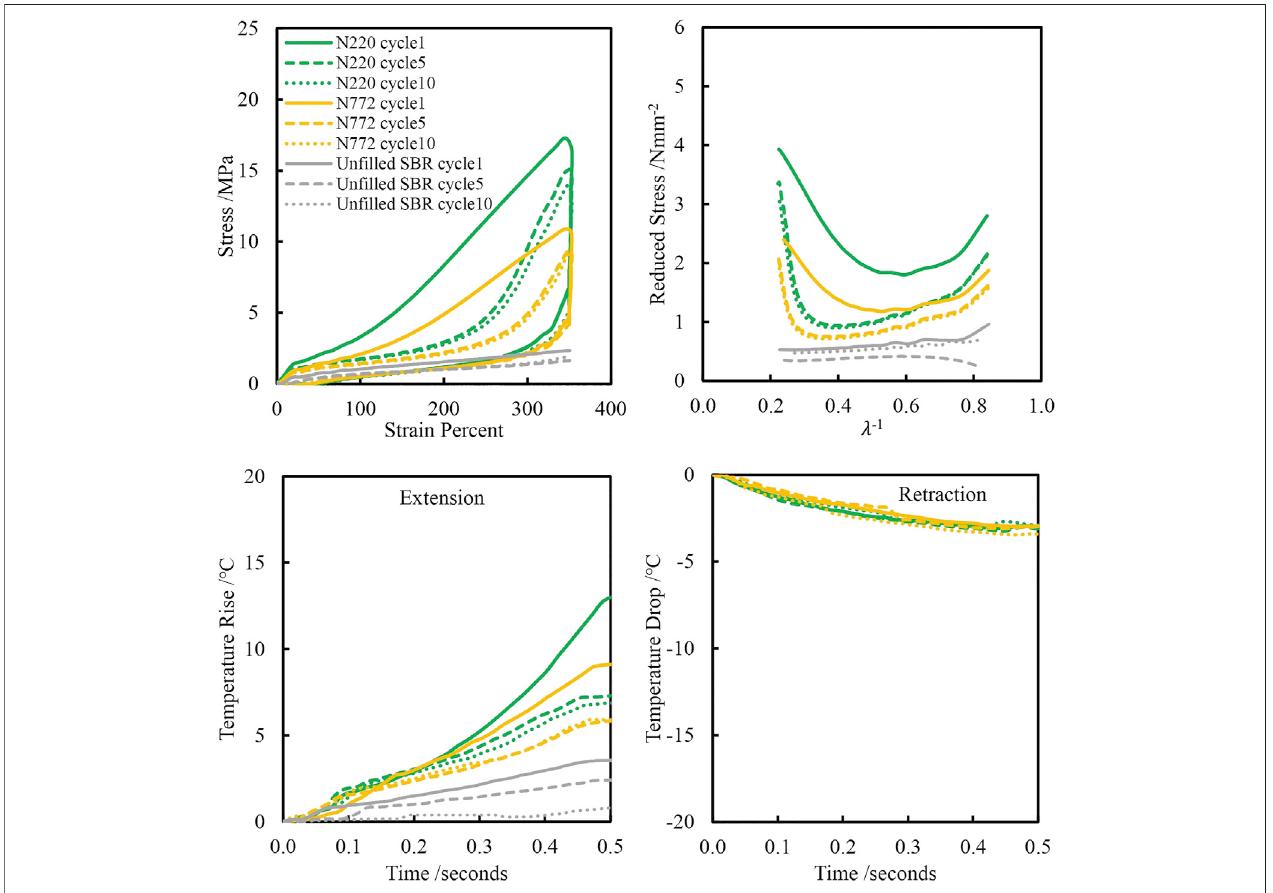
FIGURE 12 | Stress-strain, Mooney-Rivlin and temperature change plots of reinforced and unreinforced styrene butadiene rubber extended to 350% strain.